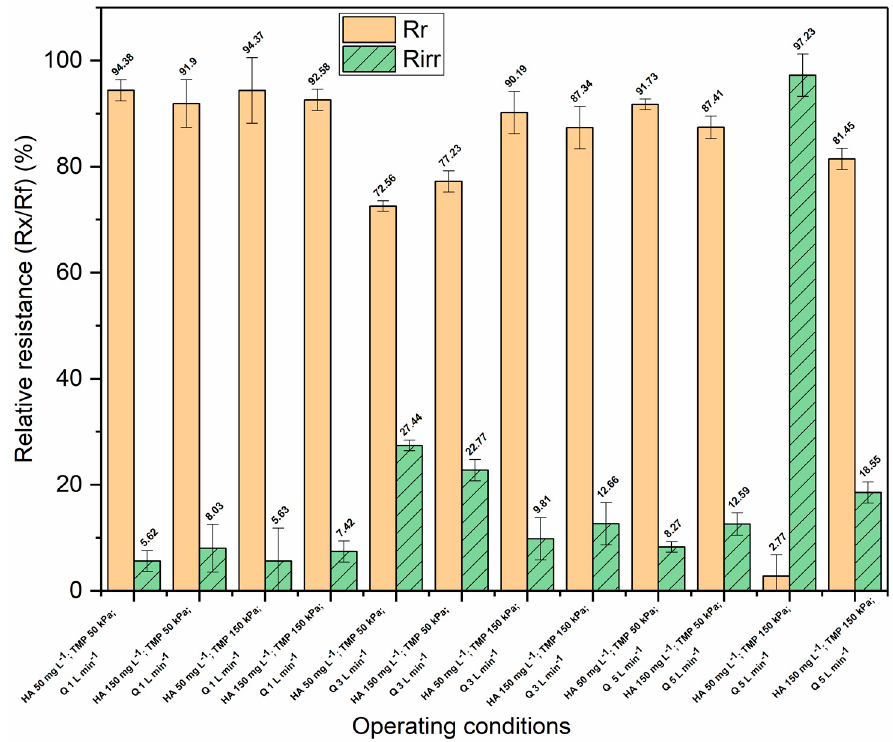
Figure 6. The relative values of irreversible ( Rirr ) and reversible resistance ( Rr ) during the ultrafiltration of a complex mixture of humic acid and colloidal silica.